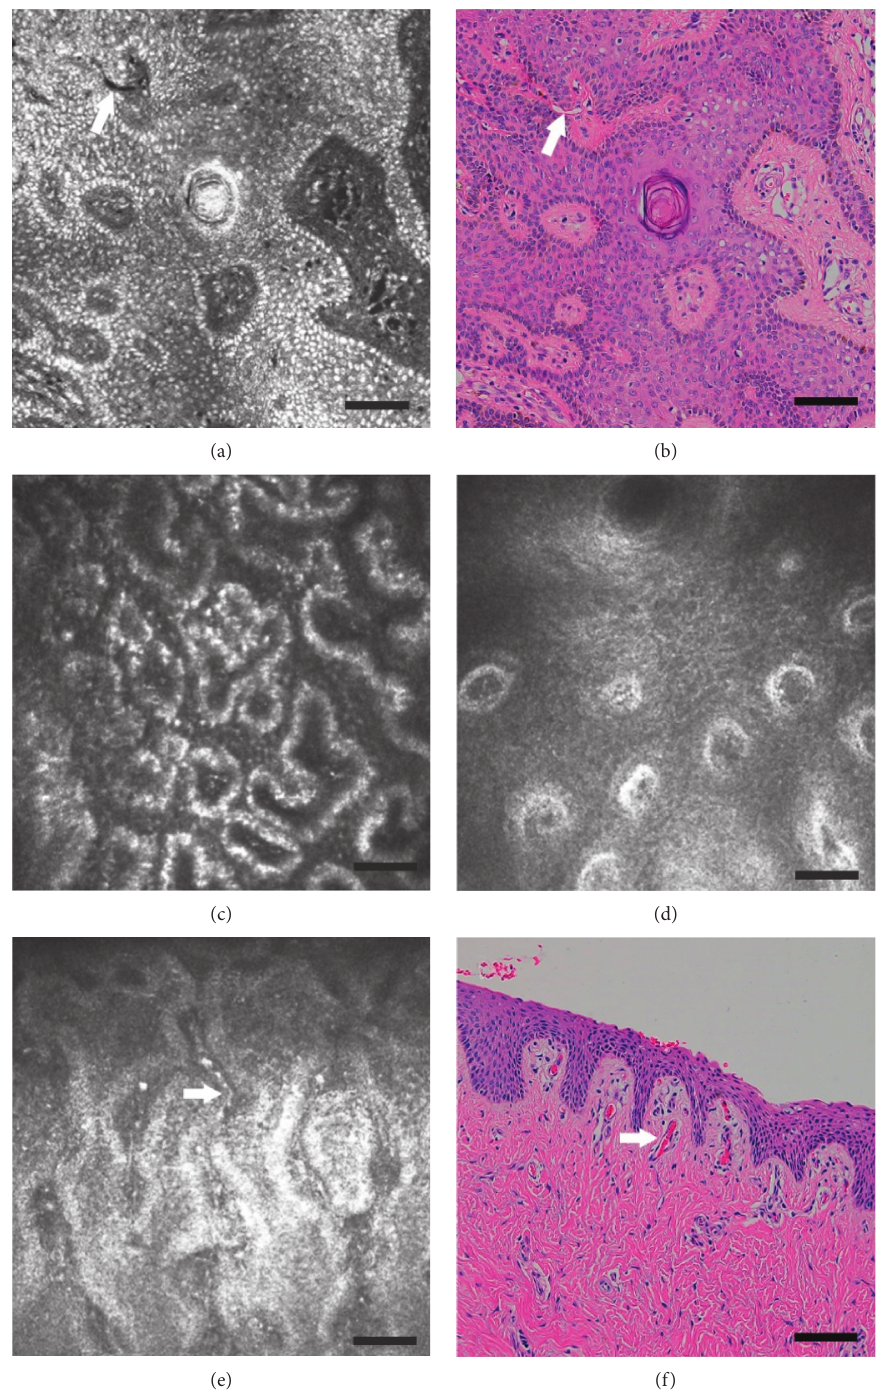
Figure 2: The cross-section of the dermoepidermal junction of the eyelid margin: (a) ex vivo confocal microscopy mode; (b) H&E stained histological section. In this part, the epidermis basement membrane surrounds the dermal papilla. In vivo confocal mode shows that the dermoepidermal junction is composed of a low-reflection area surrounded by a highly reflective layer. The dermal papilla of the skin part has a larger diameter, a higher density, and a polygonal shape (c). The conjunctival part has small diameter, low density, round shape (d). Flowing blood cells are visible in some of the dermal papilla: (e) In vivo confocal microscopy mode; the longitudinal section of H&E stained dermal papilla (scale bar: 50 μ m). Arrowheads mark capillaries filled with blood